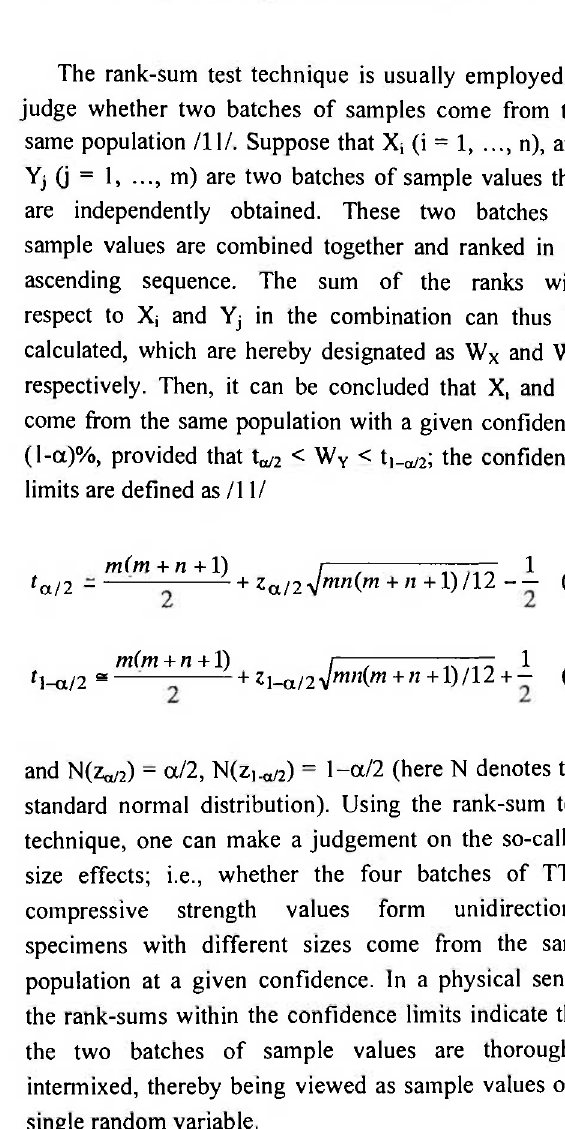
Fig. 14: Front view (from the TTH direction) of fracture surfaces in cross-ply